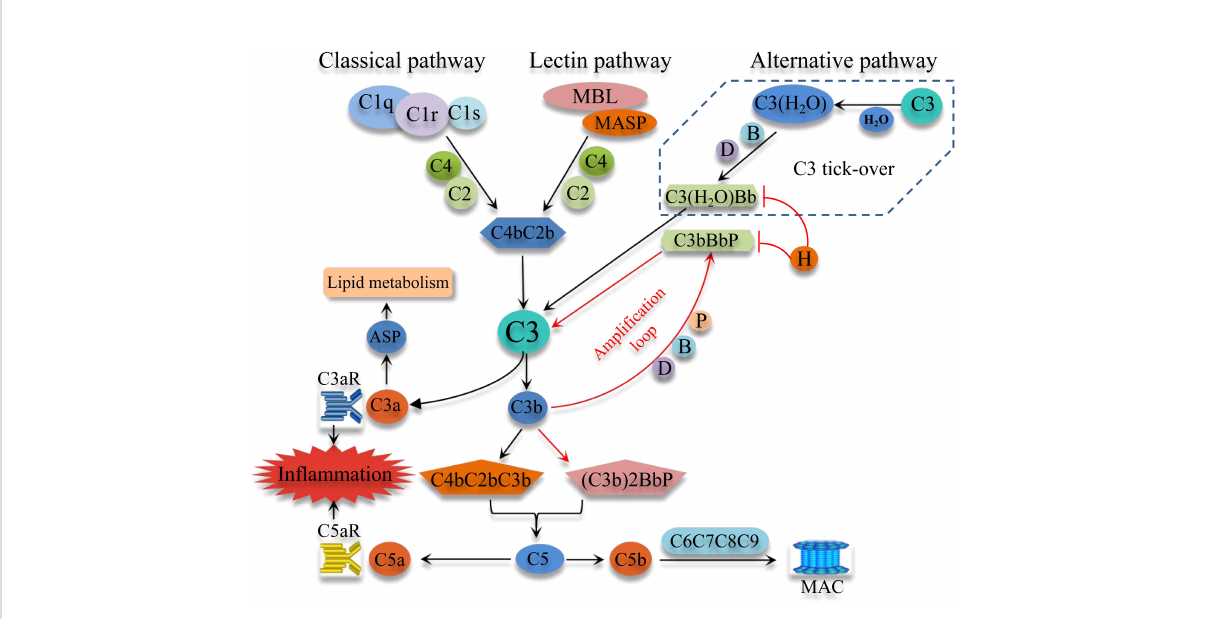
FIGURE 1 Schematic overview of the complement system activation. Complement system can be commonly activated through three pathways, the classical pathway, the Lectin pathway, and the alternative pathway (AP). Importantly, the AP can be initiated spontaneously by the “ C3 tick-over ” , which keeps AP idling and has the ability of fast-response through an ampli fi cation loop. These three pathways converge at C3 and produce C3 convertase and C5 convertase, which cleave C3 and C5, thereby generating C3a and C5a, important potent pro-in fl ammatory molecules. The activation of C5 eventually activates the downstream C6, C7, C8 and C9 to form the MAC. MBL, mannose-binding lectin; MASP, mannose- binding lectin-associated serine protease; MAC, membrane attack complex; ASP, acylation stimulating protein; B, factor B; D, factor D; H, factor H; P,